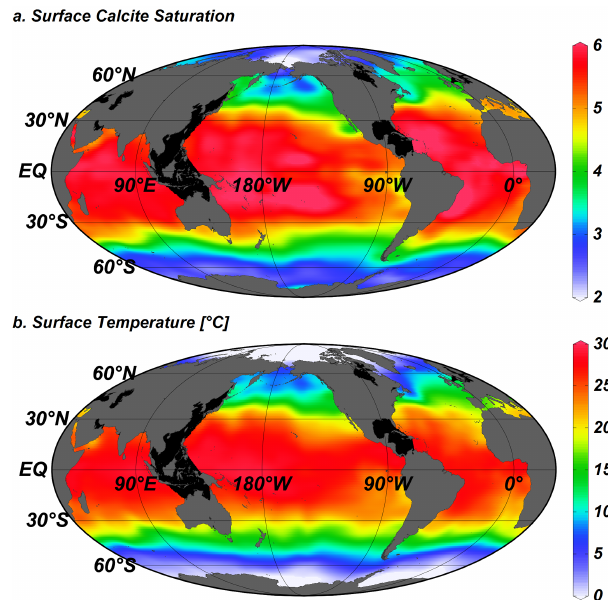
Figure 8. Gridded global (a) calcite saturation state (cid:127) C and (b) temperature at the surface (10m depth surface) of our gridded CA- RINA, PACIFICA, and GLODAP bottle data products. Areas with exceptionally poor coverage in the data used to produce the gridded product are blacked